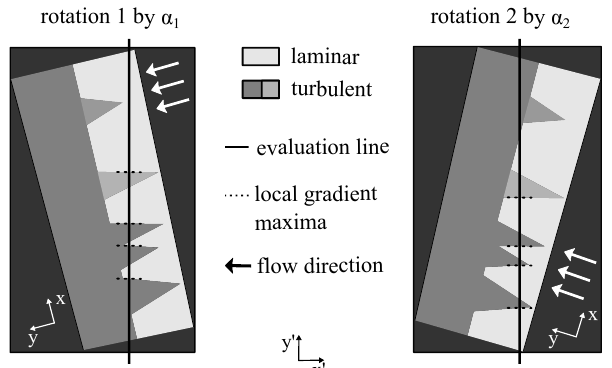
Figure 3. Sketch of the rotation motions of the thermographic image and the evaluation line (black line) parallel to the y (cid:48) -axis. The rotation angles α 1 and α 2 align one group of premature transition line segments perpendicular to the evaluation line, respectively. The angles between the evaluation line and the flow transition line (black dashed line) are almost perpendicular, increasing the sensitivity of the local gradient maxima